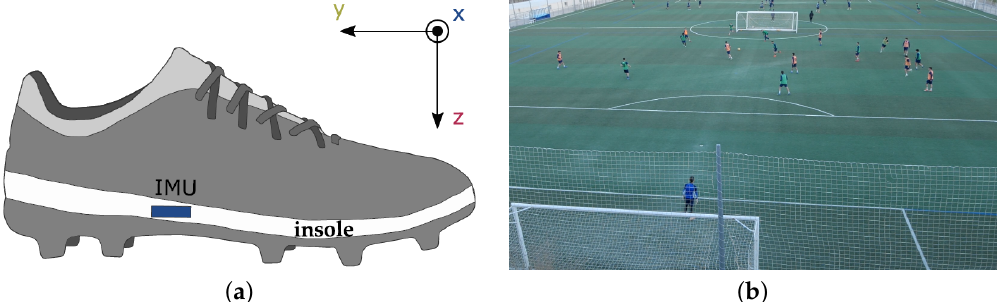
Figure 1. Hardware set up and example of in-field data acquisition. ( a ) Schematic representation of the position of the IMU sensor in the insole of a conventional football boot and the sensor coordinate system. ( b ) Example of a typical real-world data recording during a regular training session. The image shows the camera view used for